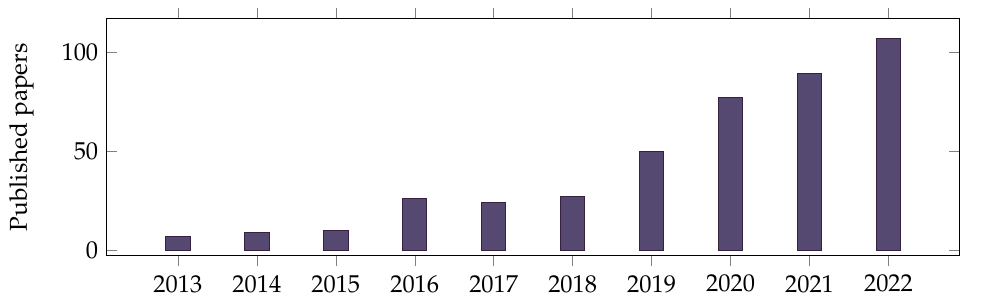
Figure 3. The number of published papers concerning machine learning applications in prediction of the electricity generation from RES.